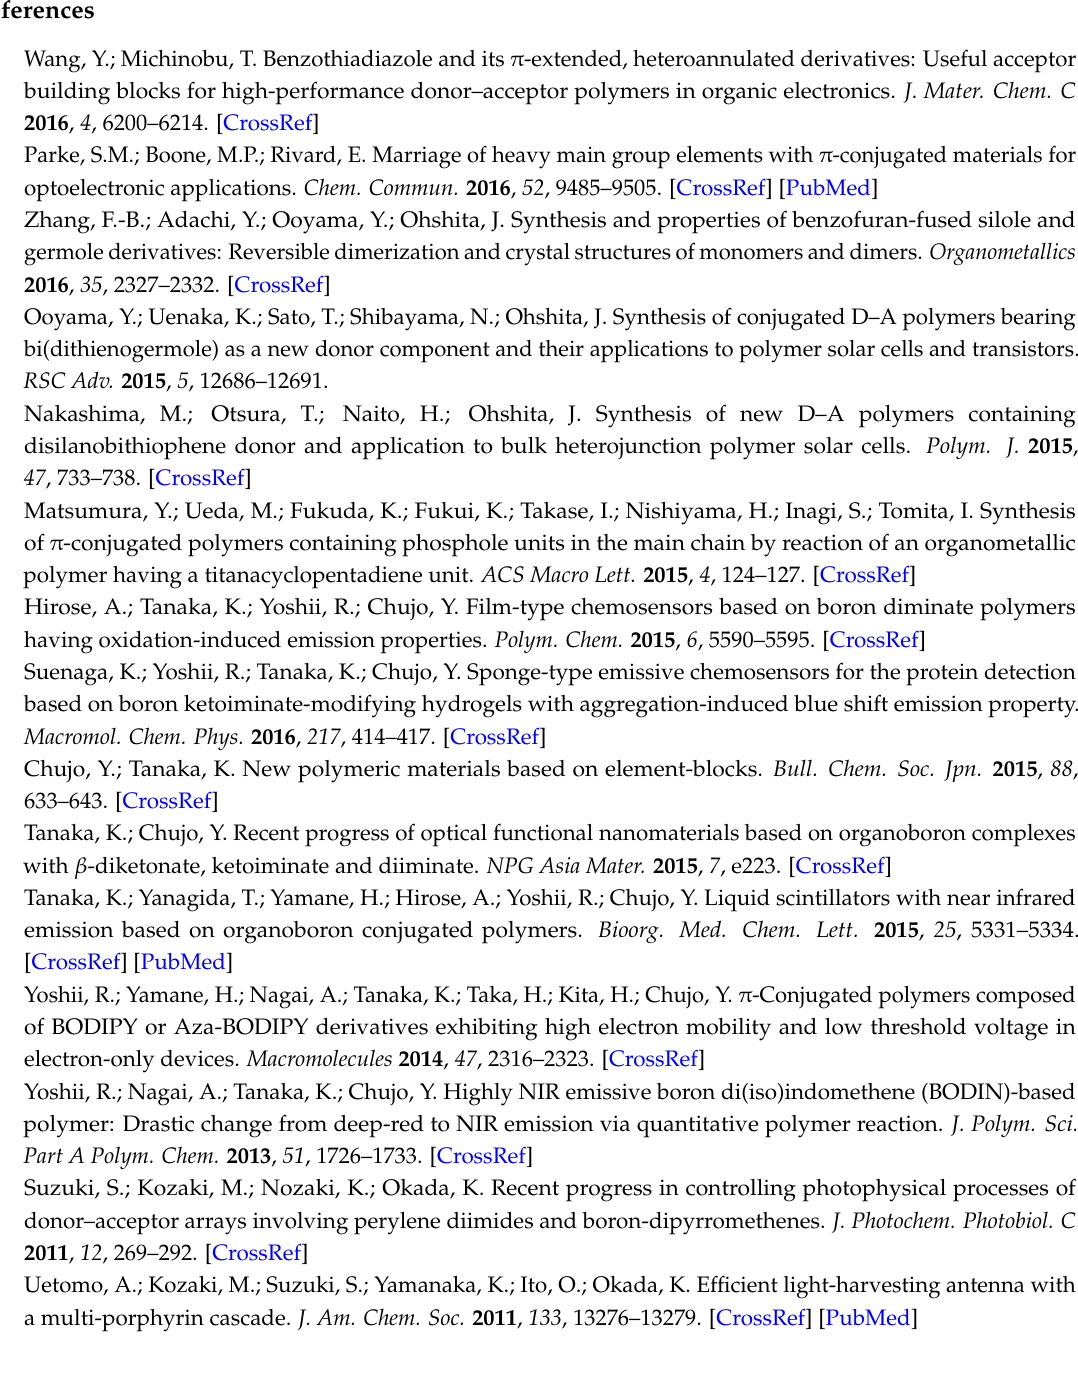
spectra, Figure S24: DFT calculation results, Figure S25: energy diagrams and molecular orbitals, Tables S1–S7: optical data for preparing the Lippert − Mataga plots, Table S8: energy levels, Table S9: assignment to electron